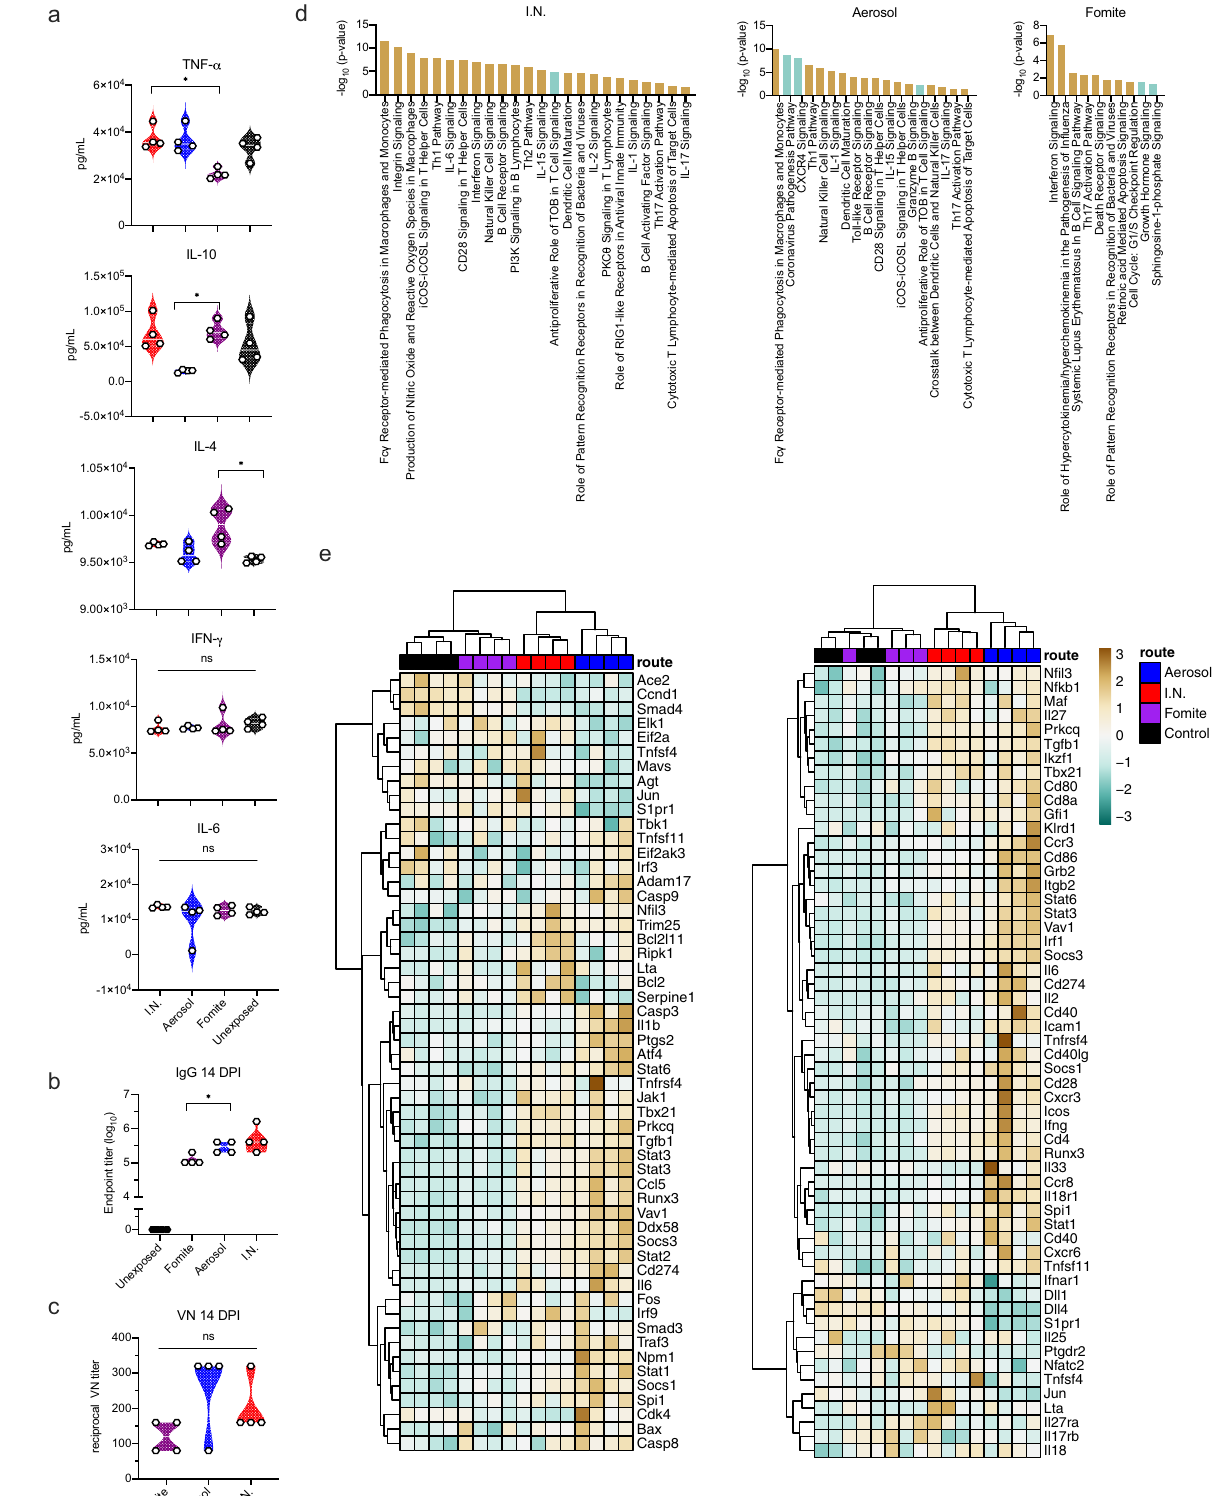
shedding pro fi le between the exposure routes, different patterns were observed. I.N. inoculation resulted in high viral loads starting at 1 DPI and continued up until 6 DPI, before sgRNA levels started to decrease. In the aerosol inoculated group, the peak of virus shedding was reached on 2 DPI and viral sgRNA levels decreased immediately thereafter. In contrast,